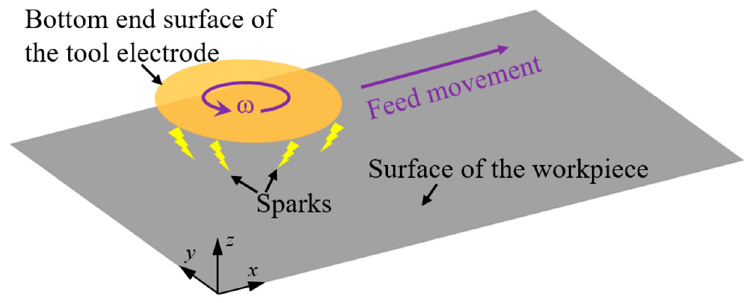
Figure 3. Schematic diagram of the simplified discharge model of micro-EDM milling.